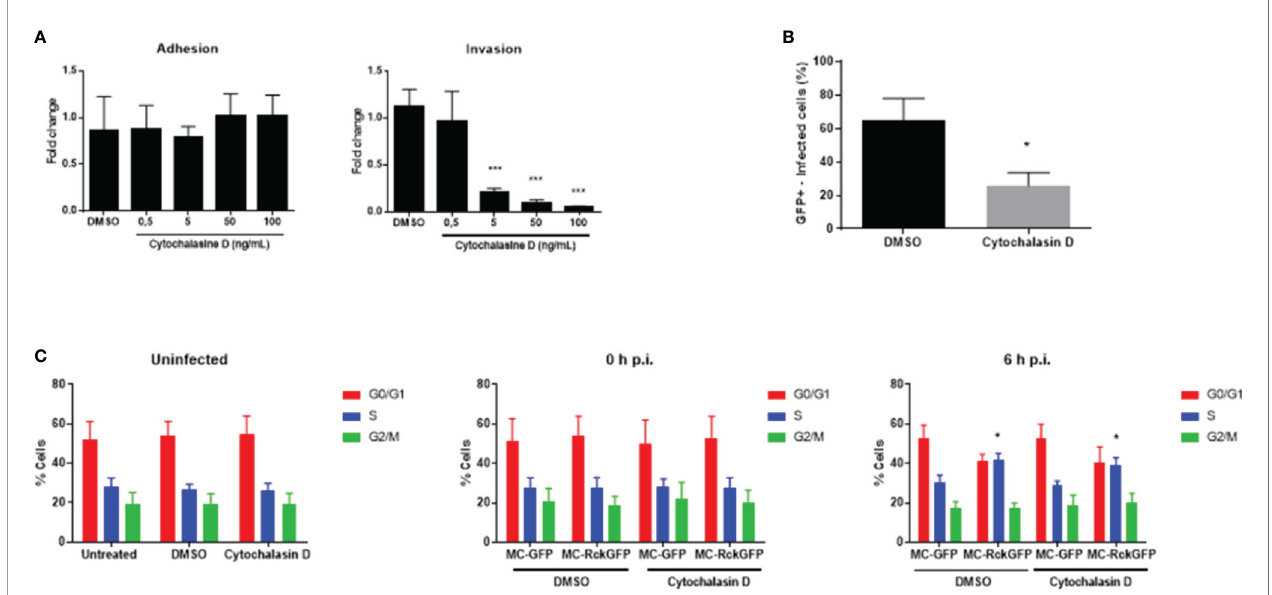
FIGURE 3 | Alteration of the host cell cycle induced by Rck is independent of the complete bacteria internalization process. HCT116 cells were treated with either increasing concentrations of cytochalasin D or DMSO as control before infection with MC-RckGFP. (A) Adhesion and invasion levels were then determined and normalized to values obtained with DMSO pretreatment, set at 1. (B, C) Cells were treated with cytochalasin D at 100 ng/ml or DMSO for 30 min and then infected with MC-RckGFP with a MOI of 100 for 1 h. (B) Following the infection, the percentage of infected cells was determined using fl ow cytometry. (C) At indicated times, cell cycle was analyzed using propidium iodide. Each data represents the mean ± SD of at least three independent experiments. A Mann- Whitney test was used to compare data from the adhesion/invasion assays (***p < 0.001; DMSO vs. Cytochalasin D) and from the fl ow cytometry experiments, (*p < 0.05; MC-GFP vs.